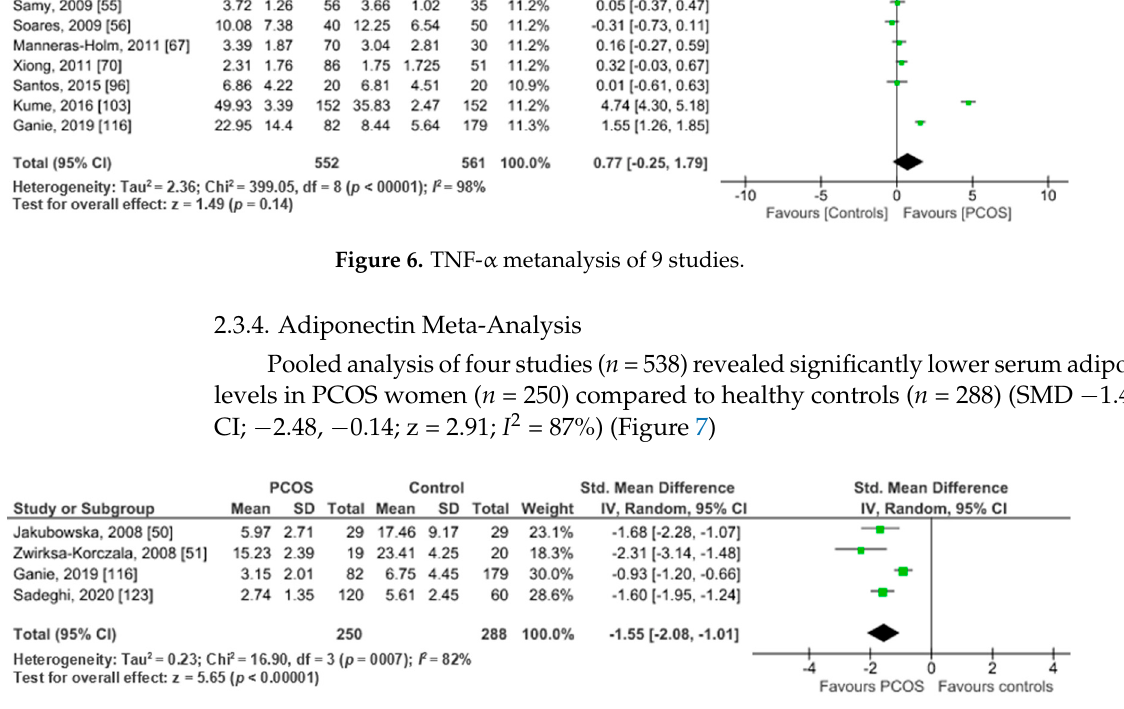
Figure 7. Adiponectin metanalysis of 4 studies.